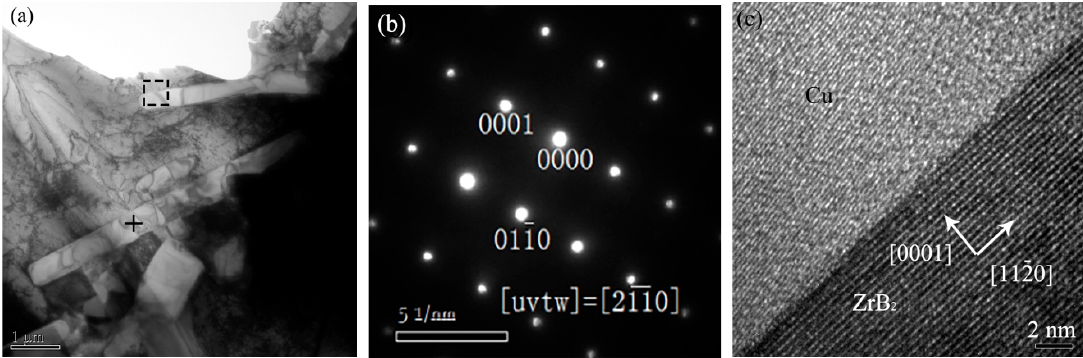
Figure 9. ( a ) TEM images of the composites (20 wt%, 66.67 kJ/cm 2 ). ( b ) Selected area diffraction patterns of ZrB 2 . ( c ) High-resolution TEM of the interface of ZrB 2 with Cu matrix.